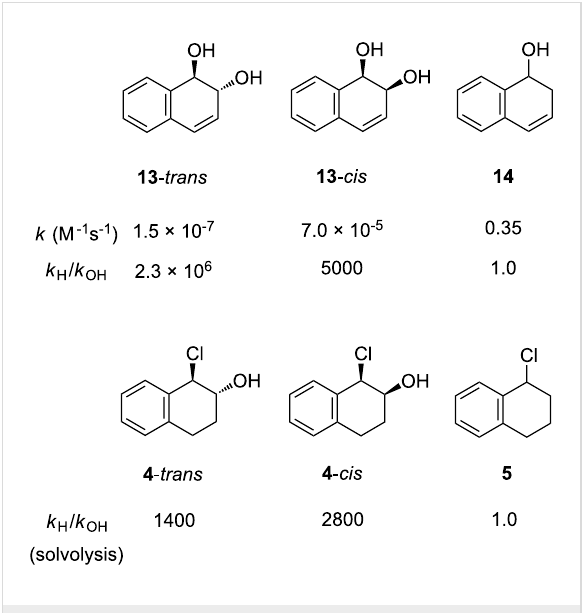
Figure 5: Comparison of the effect of a β -hydroxy group on the re- activity of cis and trans di- and tetrahdronaphthalene